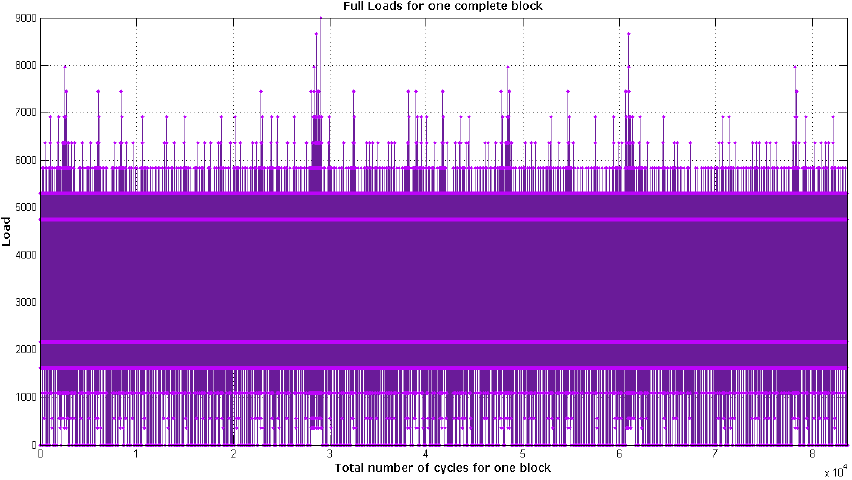
Figure 20. Distribution of loads in one complete block.